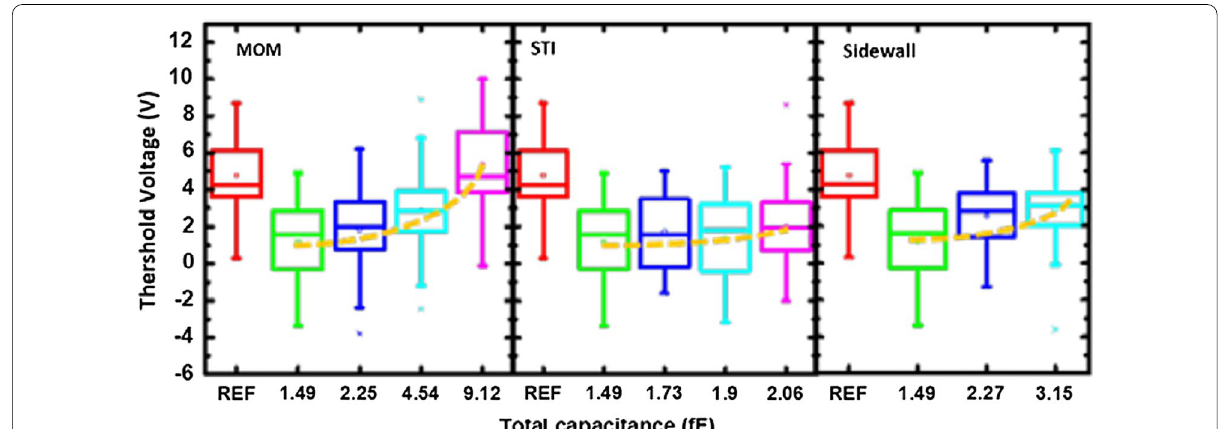
Fig. 9 Threshold voltages measured on samples with different sizes of MOM, STI and Sidewall capacitors are compared. All devices have the same AR of 1 K